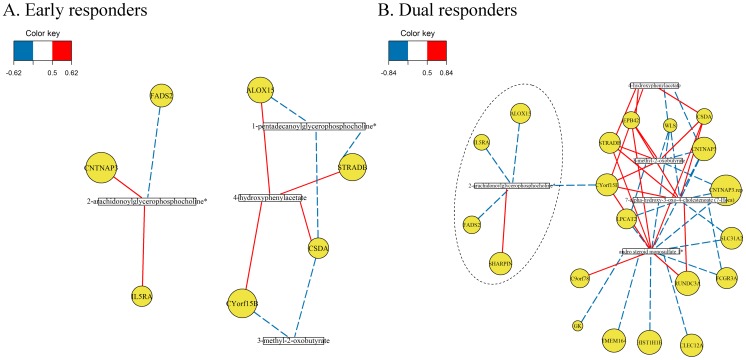
Network plots highlighting the correlation between ΔG and ΔM for early and dual responders.A. Gene-metabolite clusters for early responders (ΔG25,8 and ΔM11,8). B. Gene-metabolite clusters for dual responders (ΔG25,6 and ΔM11,6). A correlation coefficient cut-off of 0.5 is applied to both networks.